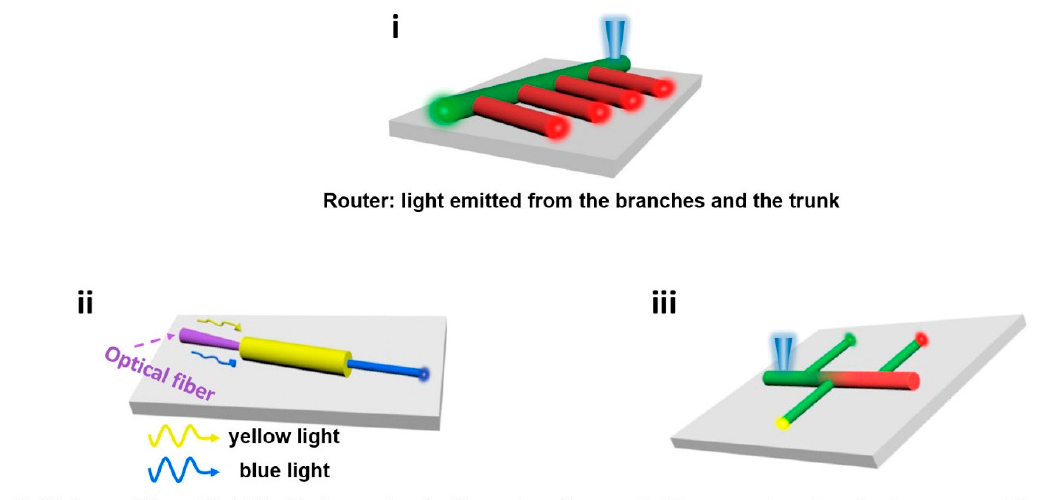
Figure 19. Schematic illustration of construction and performance study for optical components. ( i ) Multichannel router; ( ii ) wavelength division multiplexer; ( iii ) beam splitter.